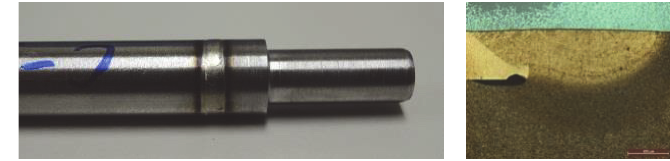
Figure 13: Weld shape with the improved weld